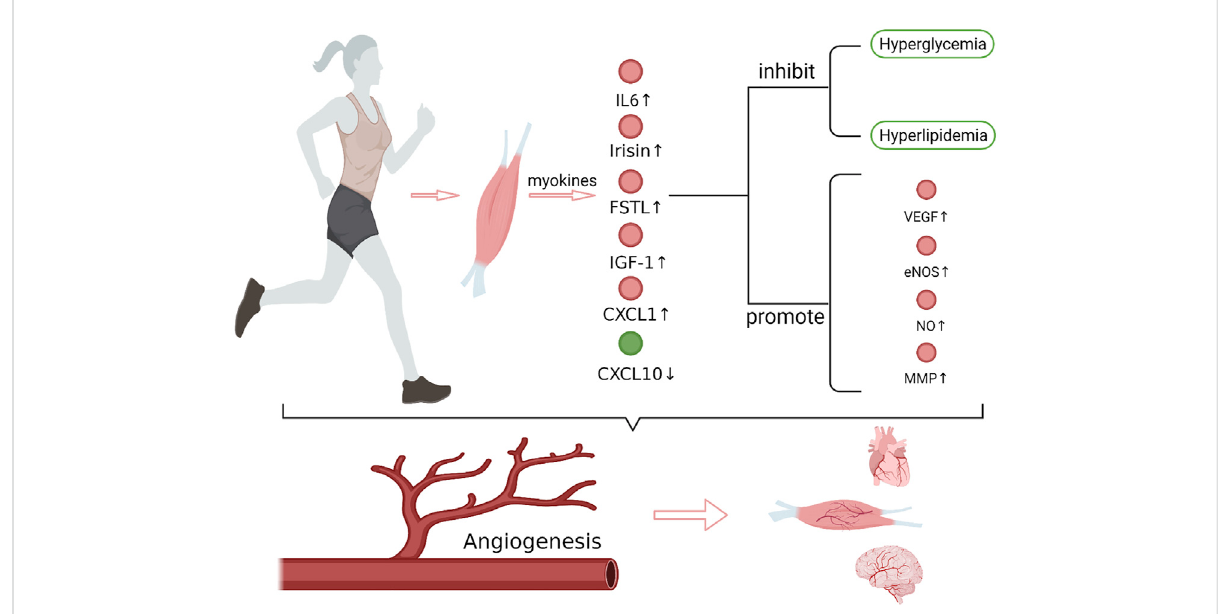
FIGURE 1 Exercise and exercise-induced myokines in promoting angiogenesis. After exercise, the expression of IL-6, irisin, FSTL1, CXCL1, IGF-1 that promote angiogenesis increased in muscles, while the expression of CXCL10, which inhibits angiogenesis, decreased. These myokines regulate the expression of angiogenesis-related factors, such as VEGF, eNOS/NO and MMP, which play important roles in endothelial cell matrix degradation, endothelial cell migration and lumen formation, and synergistically promote angiogenesis. In addition, myokines also improve hyperglycemia and hyperlipidemia. Together, these effects of myokines promote angiogenesis in brain, heart and muscle tissue. VEGF, vascular endothelial growth factor; eNOS, endothelial nitric oxide synthase; MMP, matrix metalloproteinase (Create with